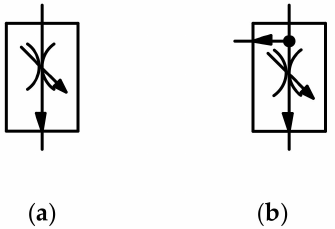
Figure 11. Flow control valves symbols: ( a ) 2-ways flow control valve (2W FCV); ( b ) 3-ways flow control valve (3W